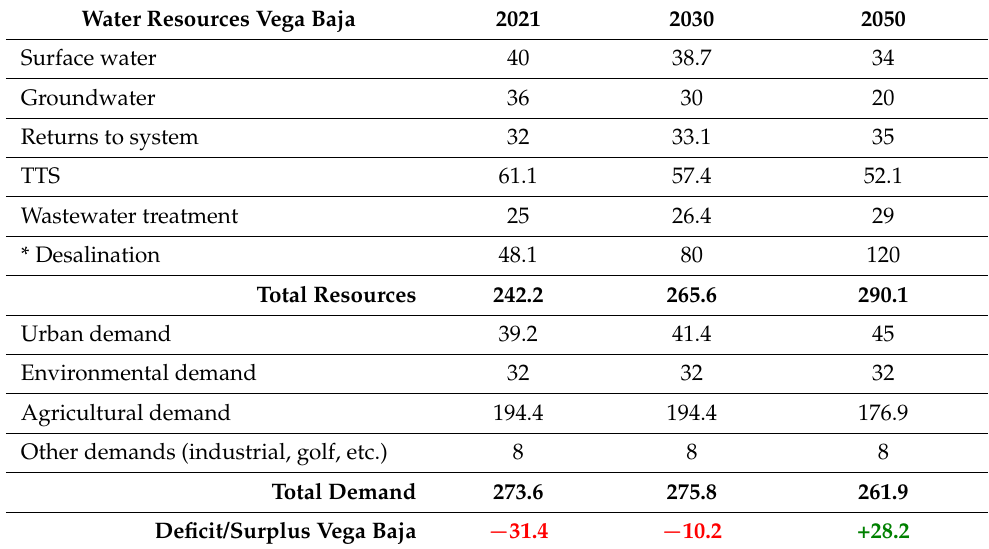
Table 9. Estimated situation for future scenarios in the Vega Baja of Segura River (2030 and 2050).